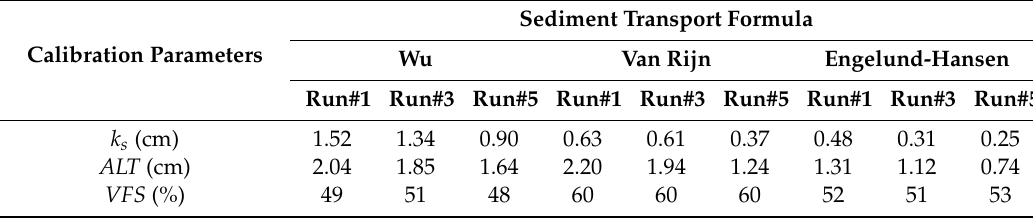
Table 4. Calibrated values of the three selected parameters for nine